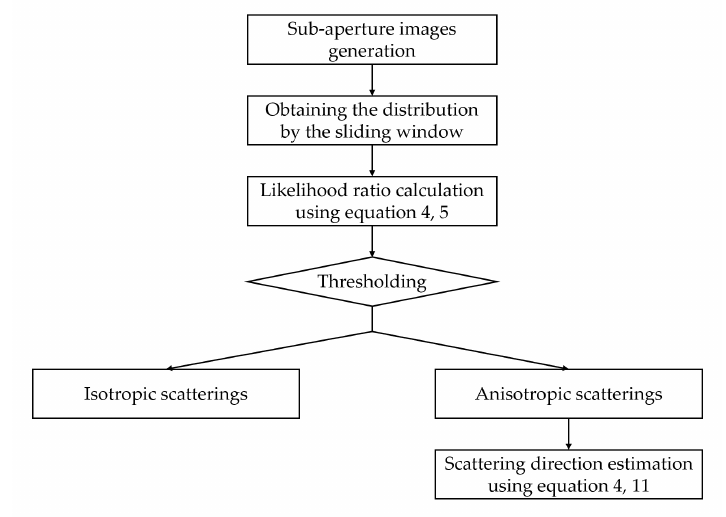
Figure 8. The flowchart of the anisotropic scattering analysis